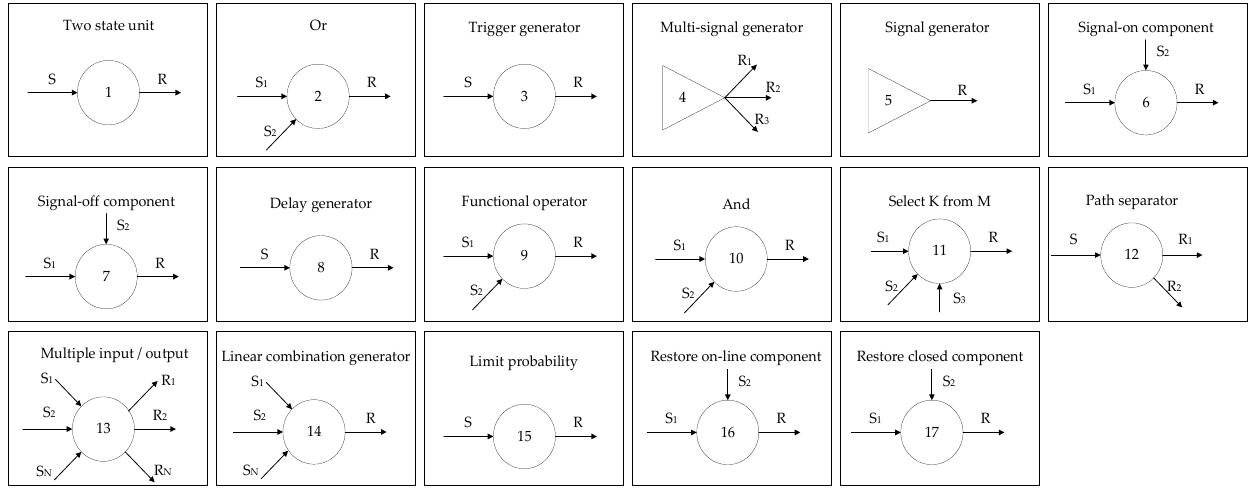
Figure 4. Standard operator types of GO methodology.